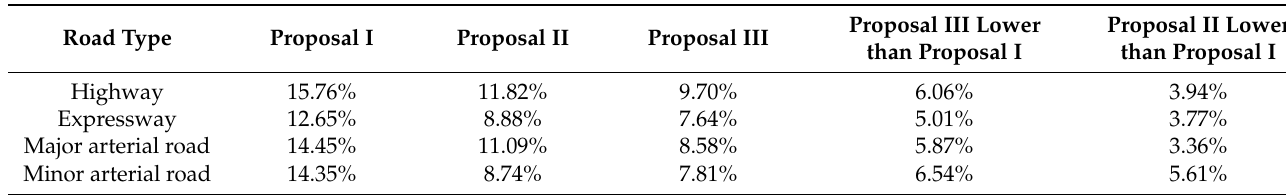
Table 6. Error between the measured flow and calculated flow of the three proposals.